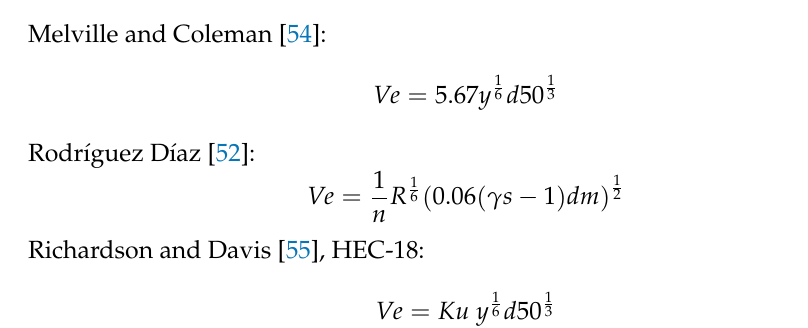
Figure 8. Erosive velocity methods comparison.